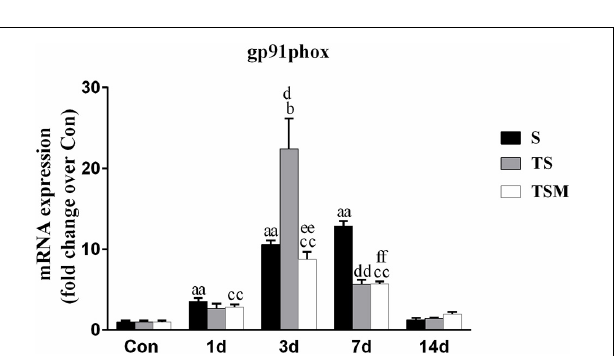
FIGURE 9 | Effects of MGF injection on the expression of gp91phox in injured skeletal muscle after macrophage depletion. S, muscle contusion group; TS, muscle contusion and macrophage depleted group; TSM, muscle contusion, macrophage depletion and MGF treated group. Data are means ± SEM, n = 8; a Significant difference from Scon, p < 0.05; aa p < 0.01. b Significant difference from TScon, p < 0.05; bb p < 0.01. c Significant difference from TSMcon, p < 0.05; cc p < 0.01; d Significant difference between group TS and group S, p < 0.05; dd p < 0.01; e Significant difference between group TS and group TSM, p < 0.05; ee p < 0.01; f Significant difference between group TSM and group S, p < 0.05; ff p <